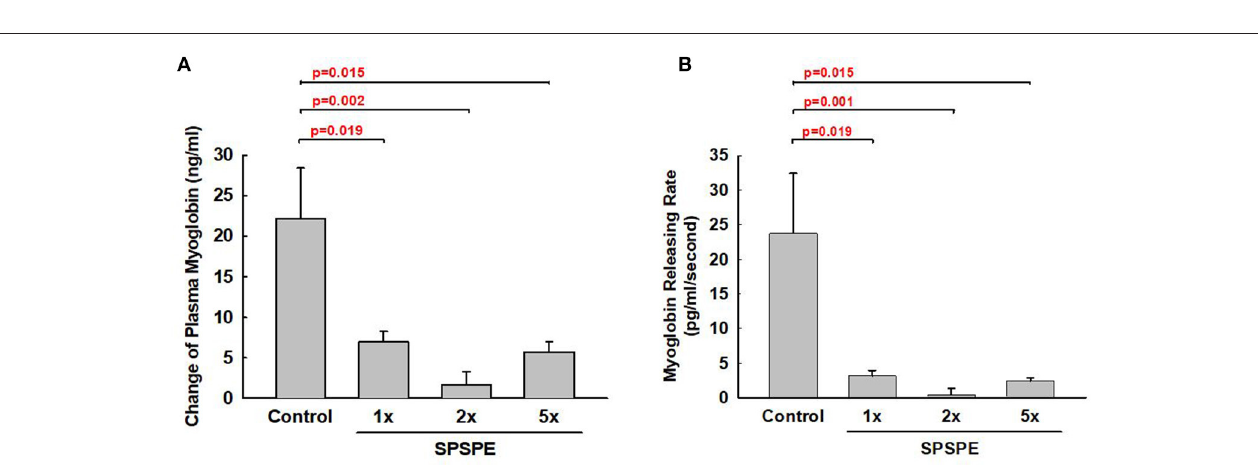
FIGURE 5 | The effects of SPSPE treatment on the plasma level of corticosterone (A) , testosterone (B) , and growth hormone (C) in rats after exhaustive swimming exercise test, each value represents Mean ± SEM, n = 9.